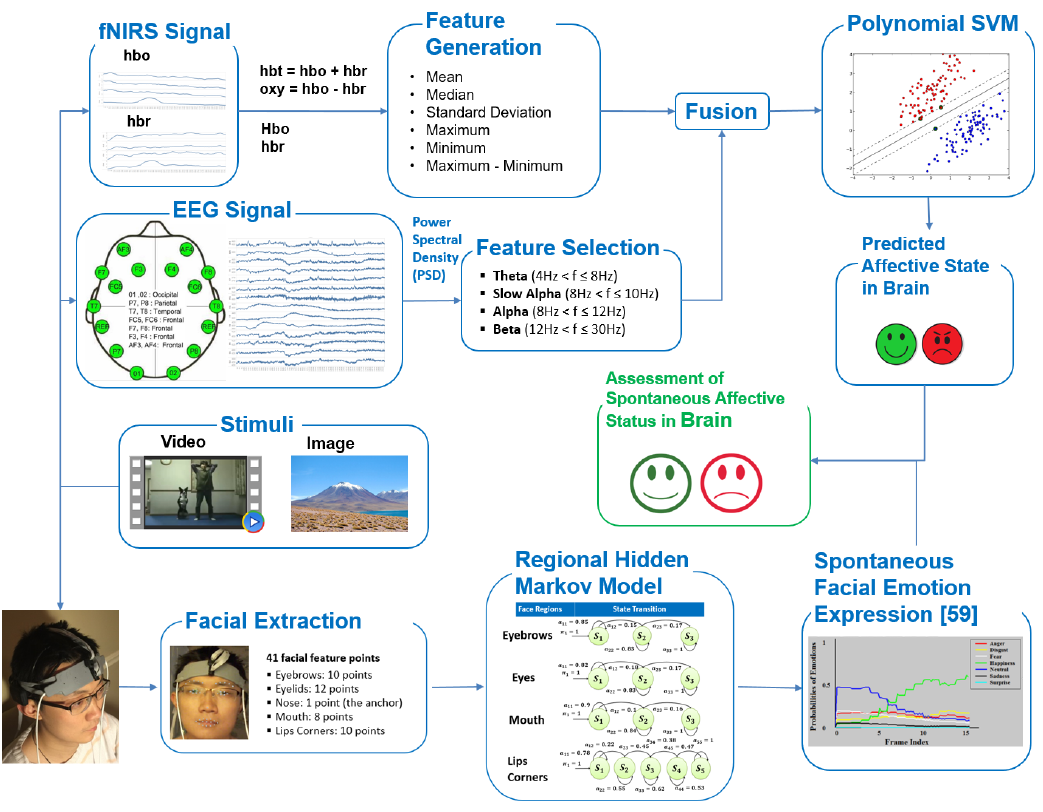
Figure 1. Framework of assessing the spontaneous affective status in brain through comparing brain activity and spontaneous facial emotions. fNIRS: functional near infrared spectroscopy; SVM: Support Vector Machine; EEG: electroencephalography.